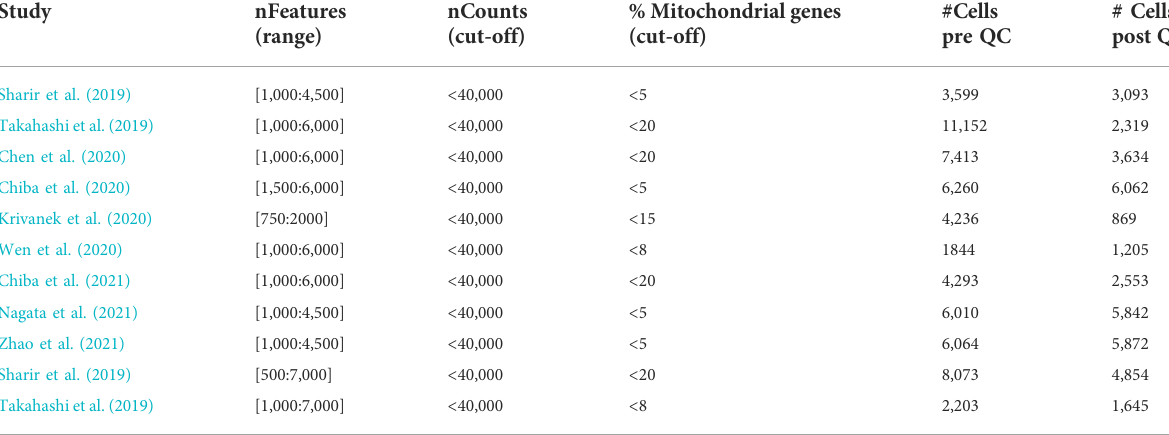
TABLE 2 Parameters used for quality control of the mouse tooth scRNA-seq datasets. Study